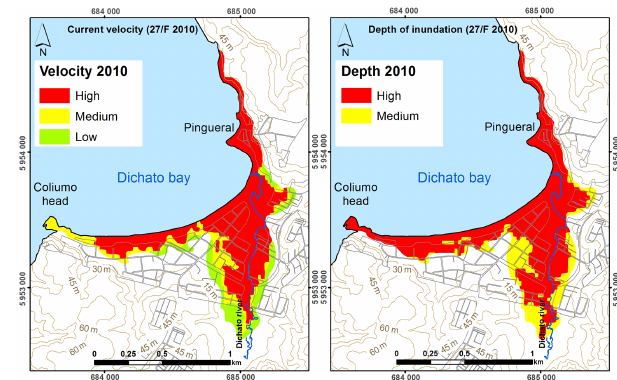
Figure 4. Tsunami hazard maps: (a) current velocity and (b) flow